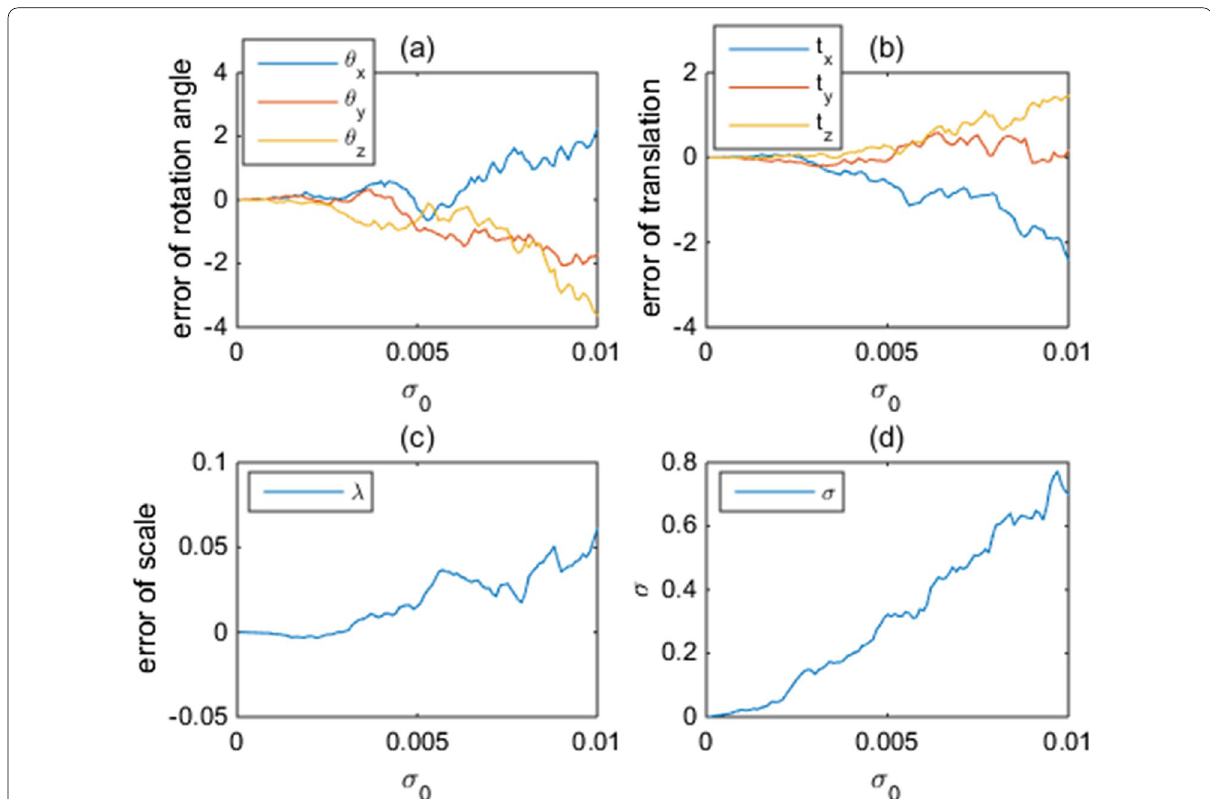
Fig. 1 The errors of computed transformation parameters and standard deviation of unit weight caused by different normal distributed random nosies N(0, σ 2 0 ). Each x axis value represents the different σ 0 in meters. Each y axis value represents different accuracy index values: ( a ) error of rotation angle, in degrees. ( b ) Error of translation, in meters. ( c ) error of scale, in no unit. ( d ) σ in